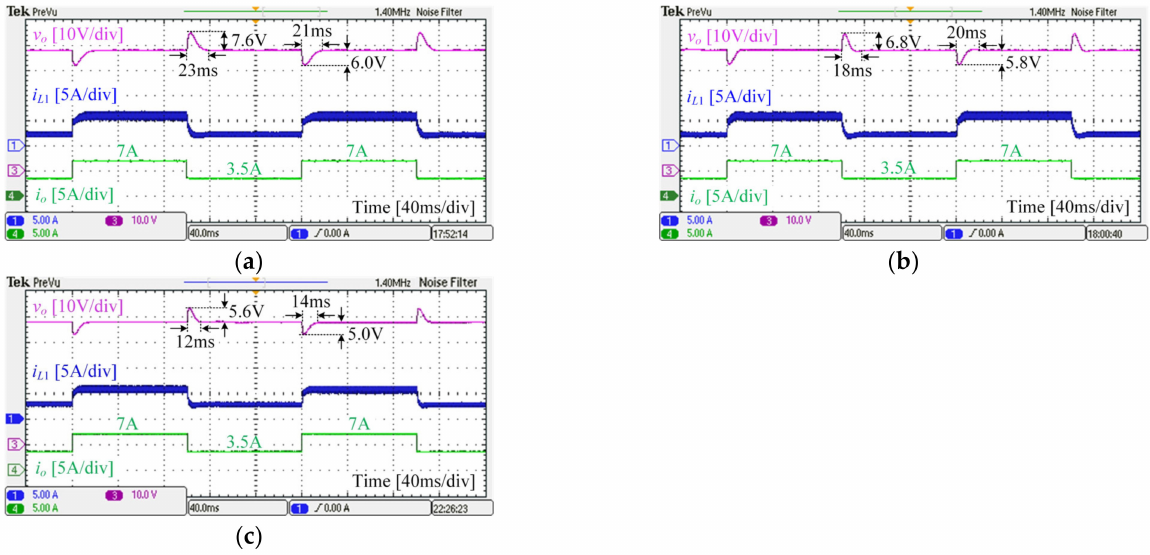
Figure 11. Experimental results of different controllers under step load current changes: ( a ) cascaded PI controller; ( b ) MPC-ESO controller; ( c ) MPC-GPIO